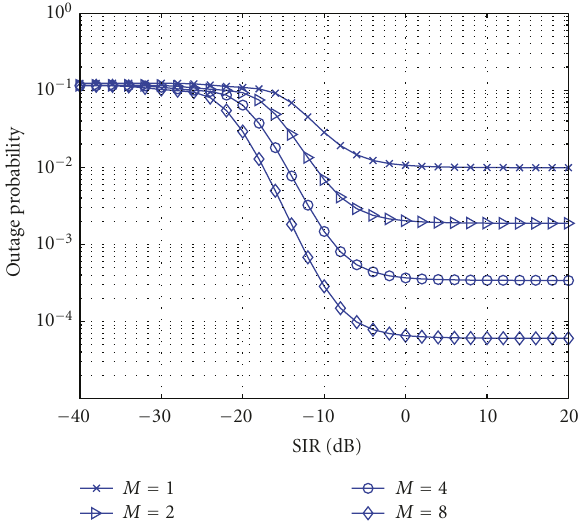
Figure 5: Outage probability of a DS/FH system, impact of beamforming, processing gain G DS = 50, the number of users K = 40, the number of interferers is J 1 = 1, J 2 = 2, J 3 = 3, duty cycles of interferes are ρ 1 = ρ 2 = ρ 3 = 0 . 2, SNR Γ N = 100 dB, the number of hopping channels N = 10, the number of multiple path L = 3, decay factor δ = 0, and protection ratio r th = 3